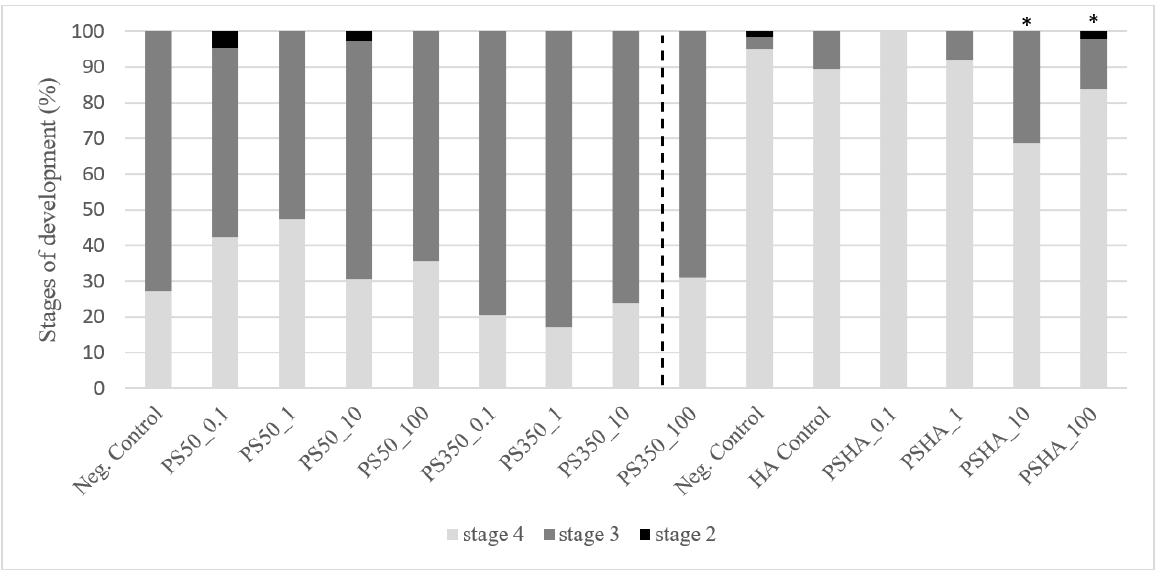
Figure 3. Stages of development of chironomid larvae exposed to PS50, PS350, and PS-HA. *: signif- icantly different from their respective control (Kruskal–Wallis test, p < 0.05).